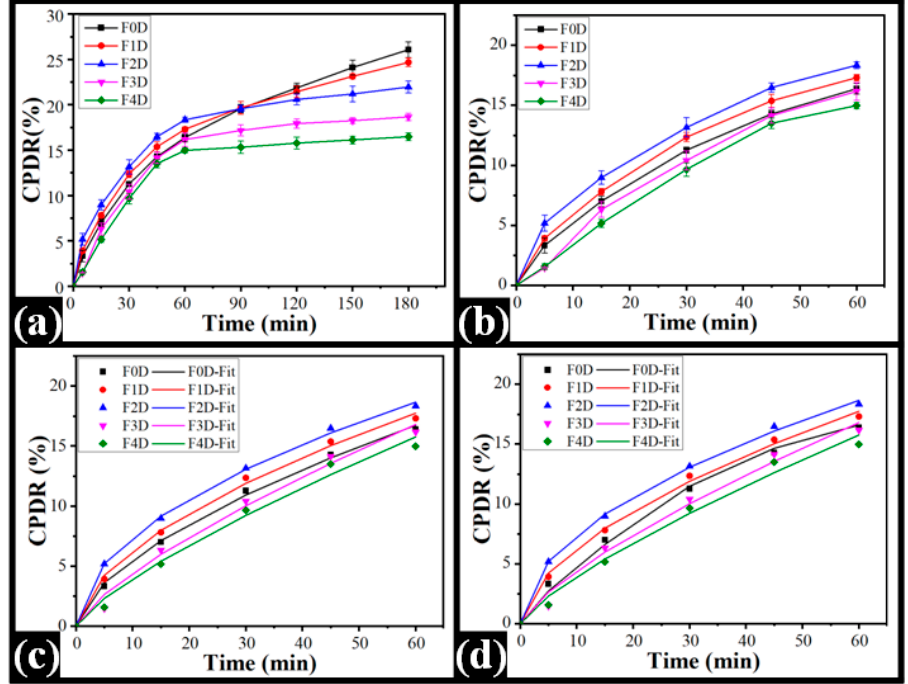
Figure 11. In vitro drug release from CPH-loaded composite films: ( a ) Profiles of %CPDR, ( b ) 60 min %CPDR profiles, ( c ) CPDR profiles fitting to KP model, and ( d ) PS model fitting of the CPDR profile.